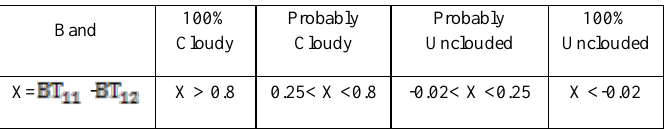
Table 6: Acquired thresholds for BT 11 - BT 12 (April 20 th )